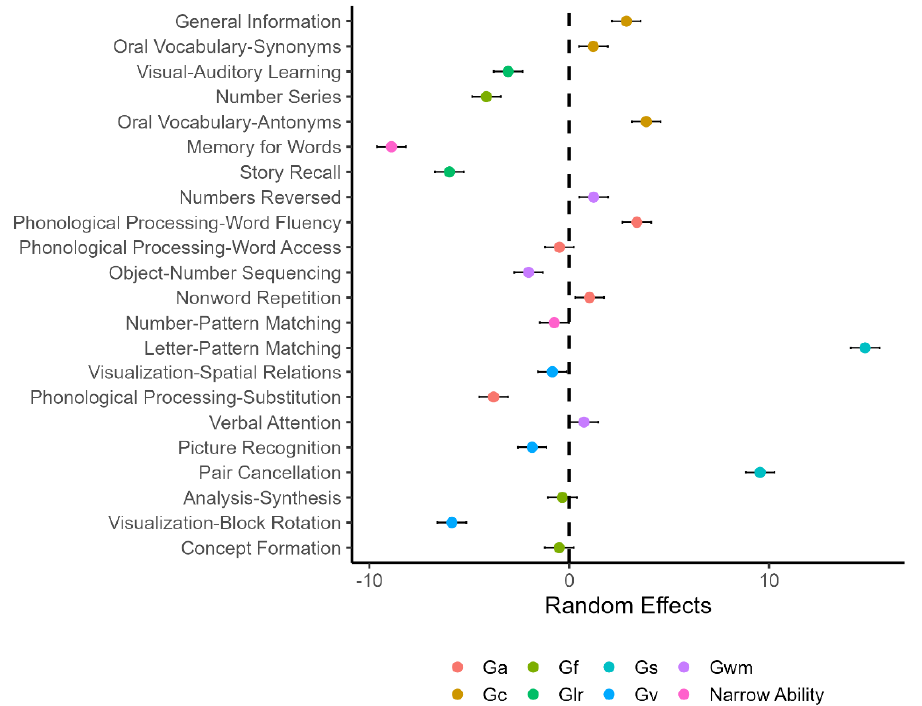
Figure 1. Estimated random effects and 95% confidence intervals for the tests in Model 1 (note: The dashed line represents the overall average score. The subtests on the y -axis are sorted in descending order by linguistic demand of the test directions).